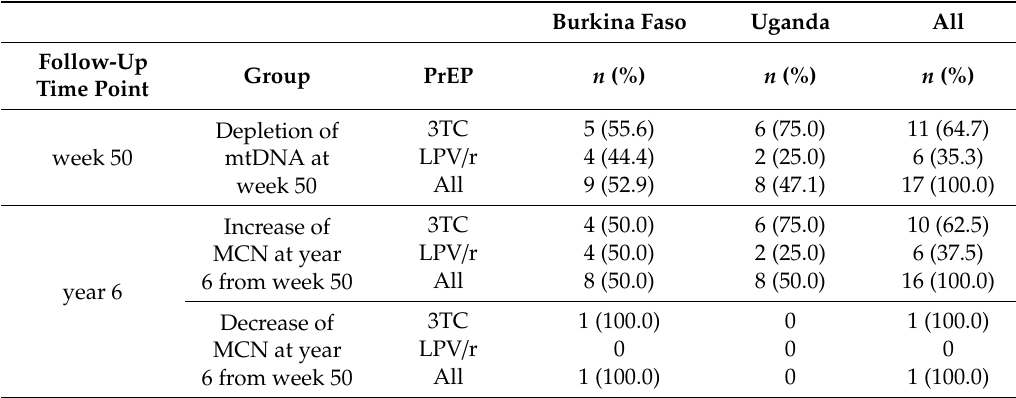
Table 3. Mitochondrial DNA depletion among CHEU by time point.